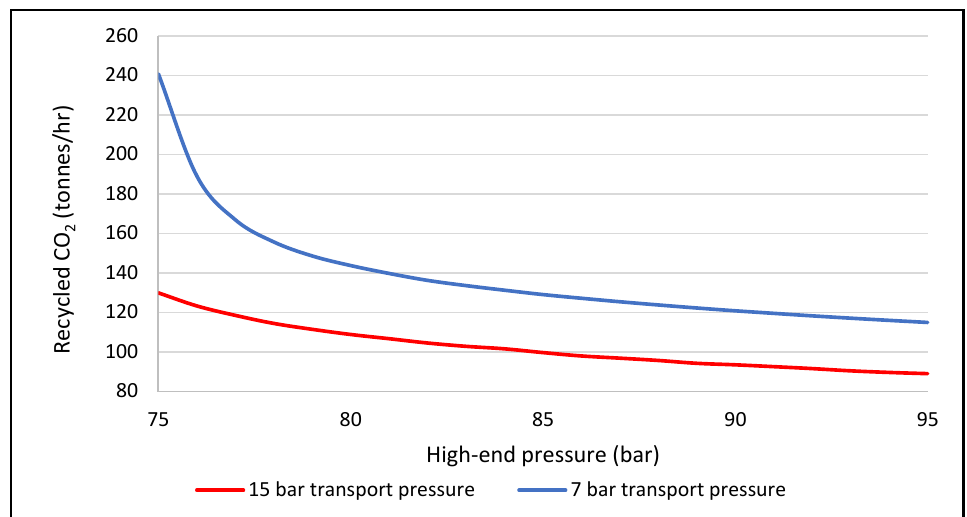
Figure 4. Effect of the high-end pressure (x-axis) on the CO 2 recycling flow rate (y-axis).